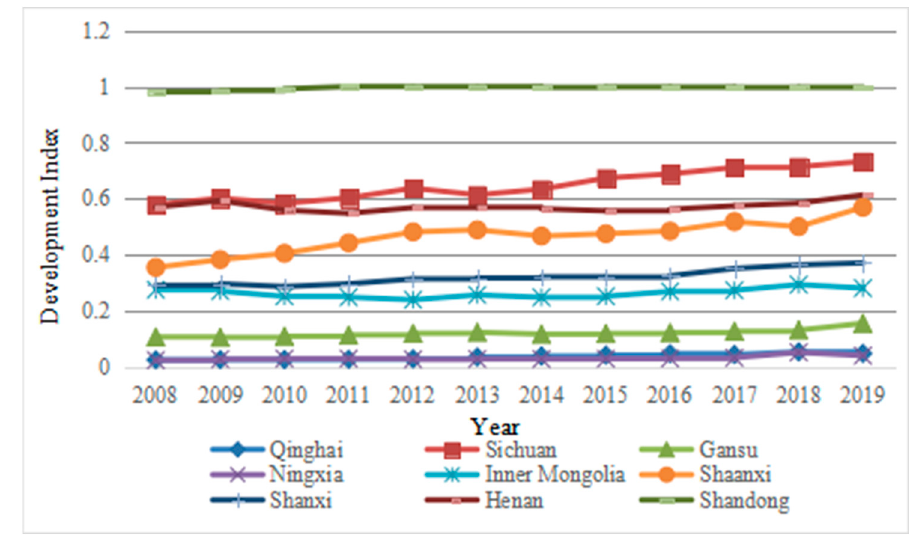
Figure 1. Development Status of Tourism in the Yellow River Basin from 2008 to 2019.